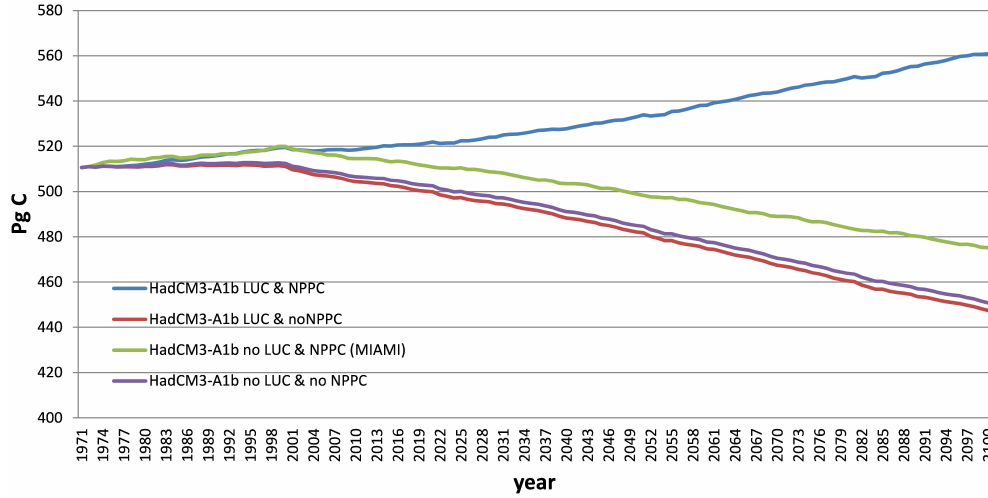
Fig. 6. Simulated changes in SOC stocks for four experimental set-ups using the climate scenario data of the HadCM3 AOGCM in con- junction with A1b. Blue line: simulation including land use and NPP change; the latter is based on IMAGE NPP which includes the CO 2 - fertilisation effect. Green line: simulation including no land use change but NPP change; the latter is based on temperature and precipitation changes only. Purple line: simulation including neither land use nor NPP change. Red line: simulation including land use change but no NPP change.